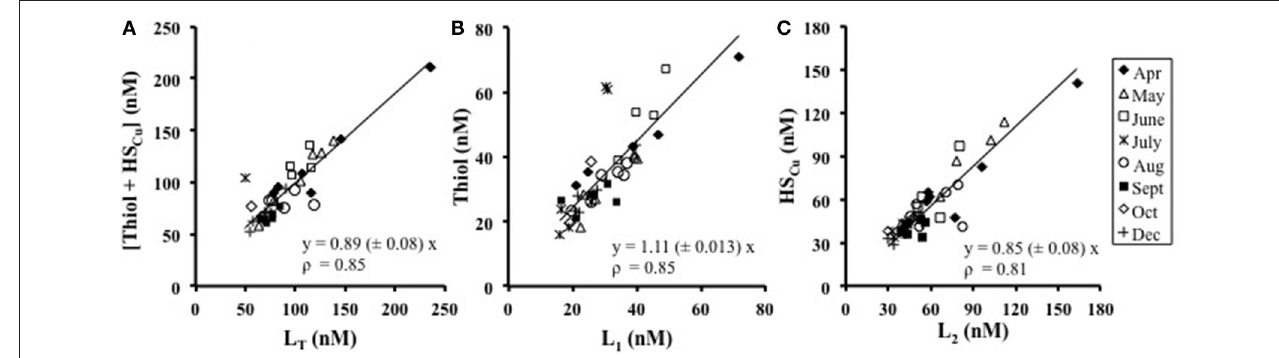
FIGURE 4 | The relationship between the concentrations of (A) [Thiol + HS] against the total ligand (L T ), (B) thiourea-type thiols against L 1, and (C) HS Cu against L 2 . Thiol measurements are in thiourea equivalents (nM) and HS Cu are on the nM scale by multiplying with the binding capacity of 18 (Whitby and van den Berg, 2015). April data includes the freshwater end-member station 10 sampled in April.